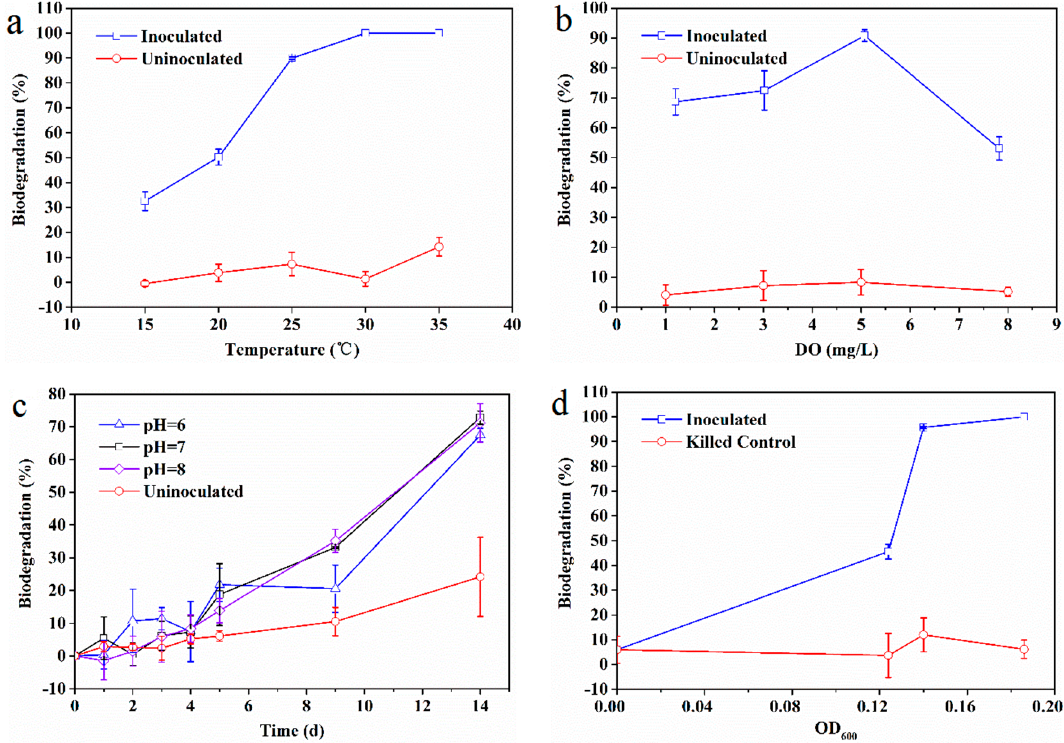
Figure 3. Effect of ( a ) temperature, ( b ) DO, ( c ) pH, and ( d ) biomass on EDB biodegradation by the microbial consortium at 25 °C.